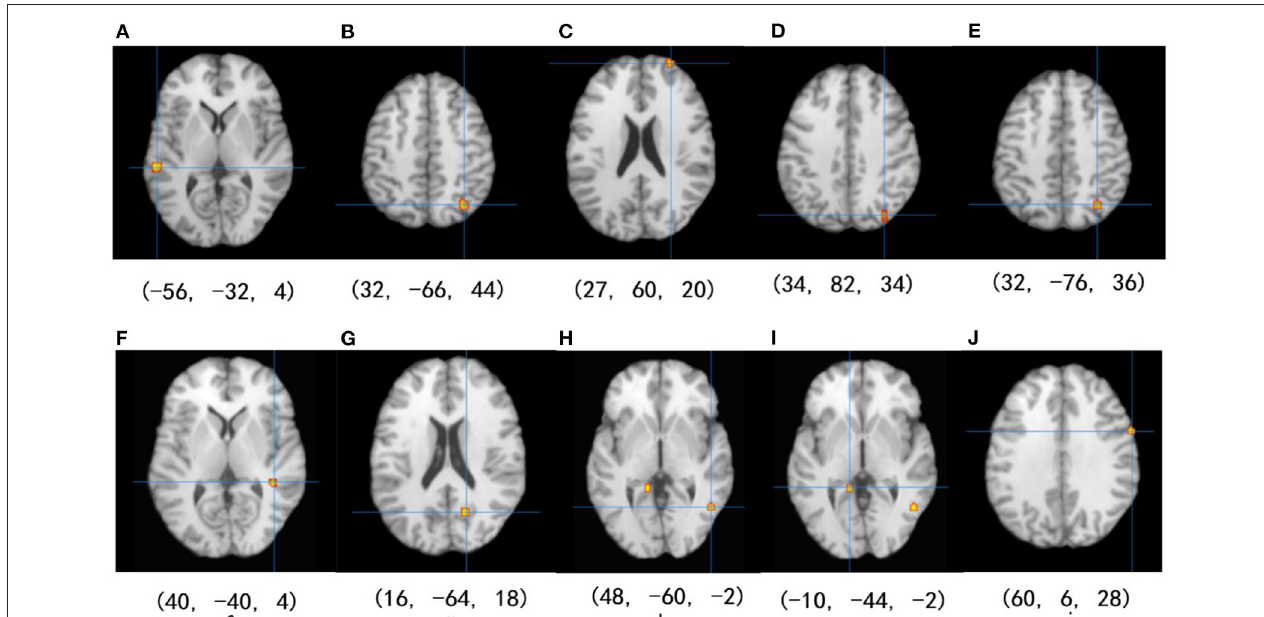
FIGURE 2 | Results of the ALE meta-analysis show increased and reduced activation for inhibitory control in the EGs compared with CGs. Uncorrected p < 0.001 and cluster size > 100 mm 3 (from A–D : activation is increased, and from E–J : activation is decreased).